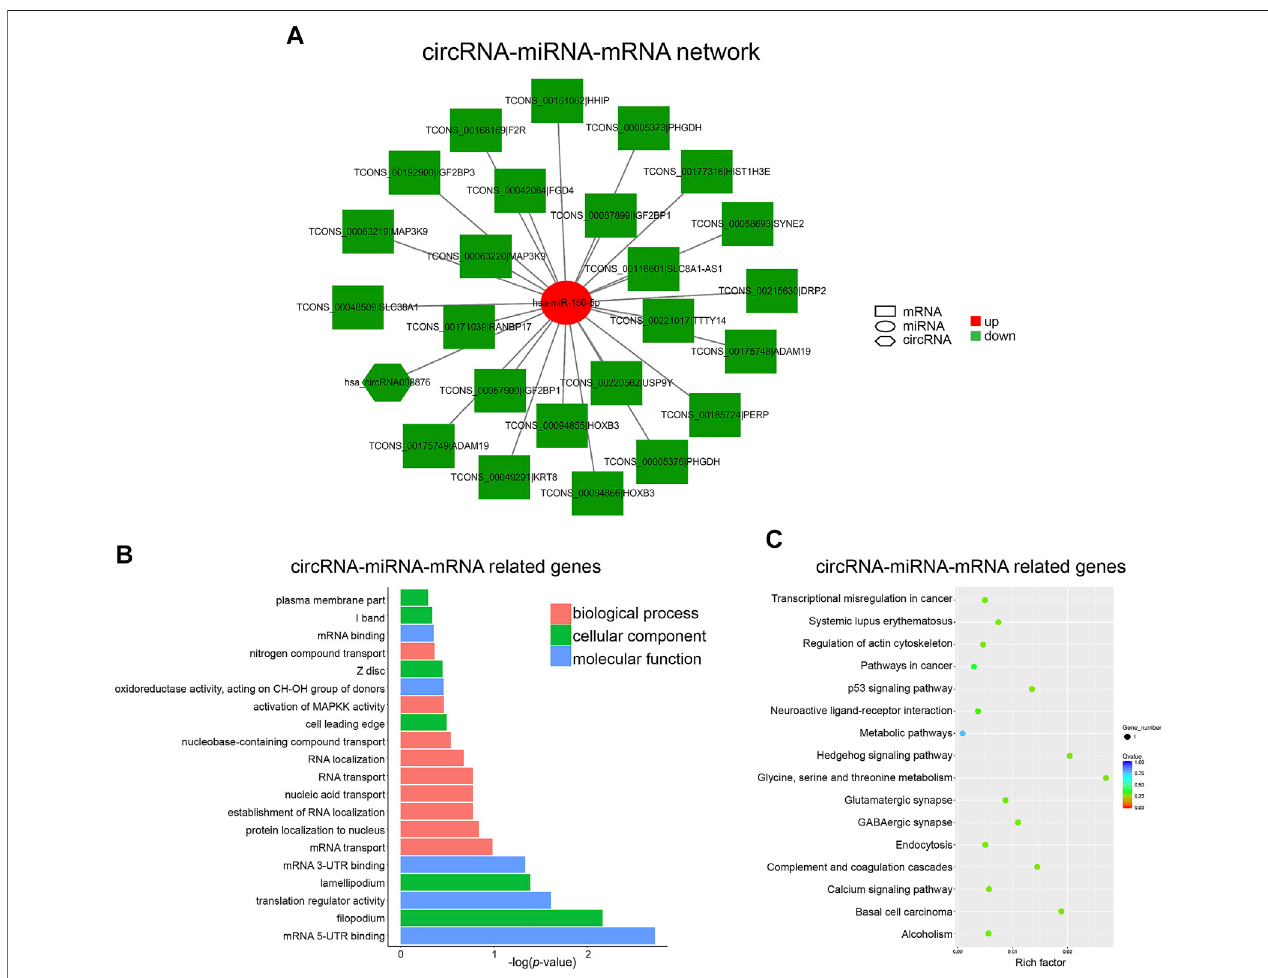
FIGURE 6 | Construction of the circRNA-miRNA-mRNA Network. (A) circRNA-miRNA-mRNA network was constructed with down-regulated circRNA_008876 and up-regulated miR-150-5p. (B) Top 20 GO terms analyzed with mRNAs in circRNA-miRNA-mRNA network. (C) Top 20 KEGG pathway enrichment of mRNAs in circRNA-miRNA-mRNA